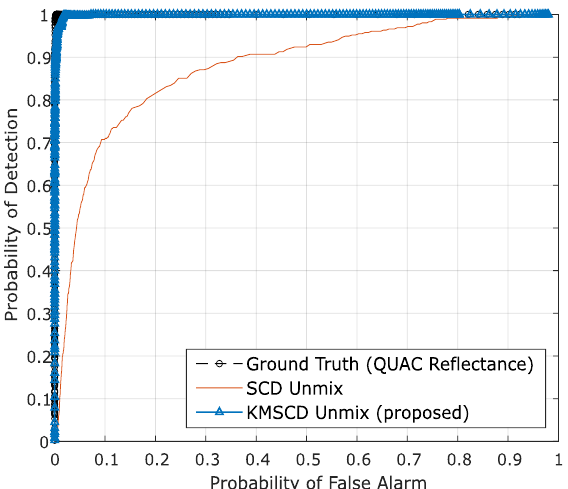
Figure 8. The receiver operating characteristic (ROC) for the detection of the Orange Perspex targets from the Selene Dual scene reconstructed by the C-SCD and KMSCD algorithms. The small orange targets are seen to be ~12% better detected from the KMSCD reconstructed